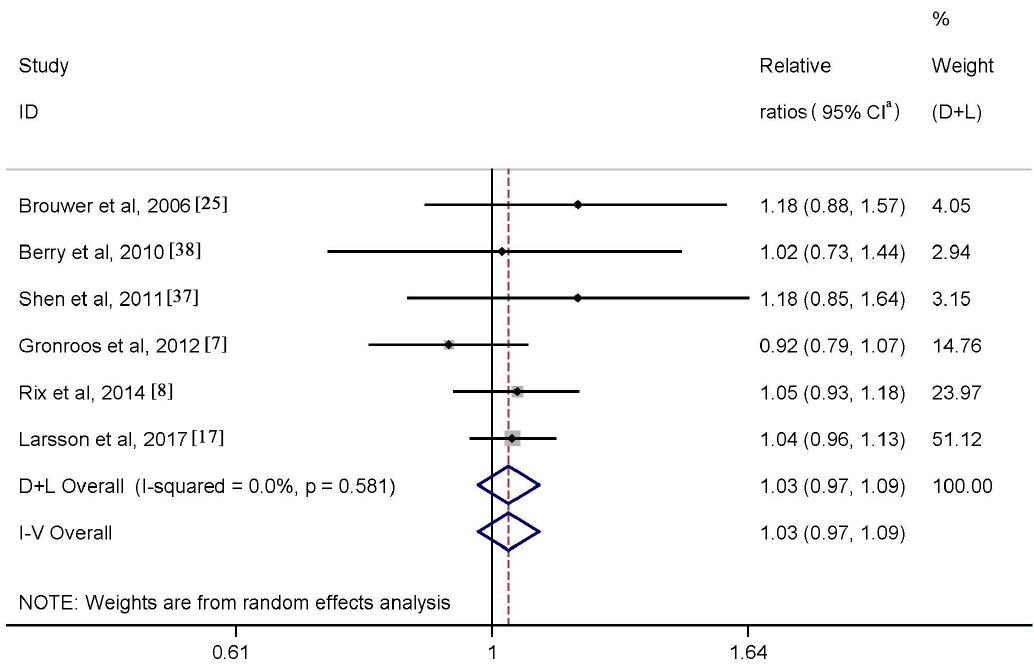
Figure 3. Meta-analysis of n -3 PUFAs intake and AF risk (highest vs. lowest). a CI: confidence intervals.